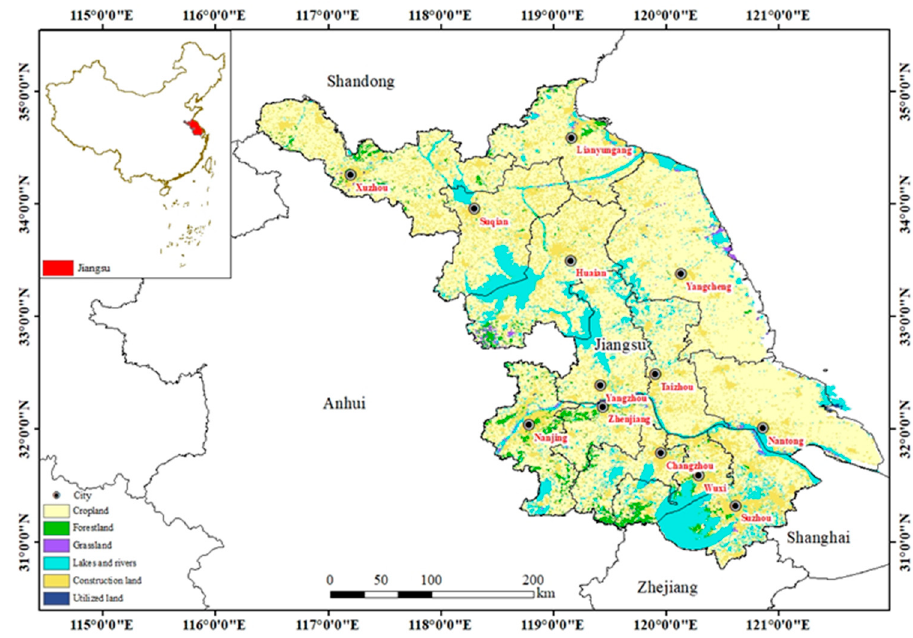
Figure 1. Location of the study area.